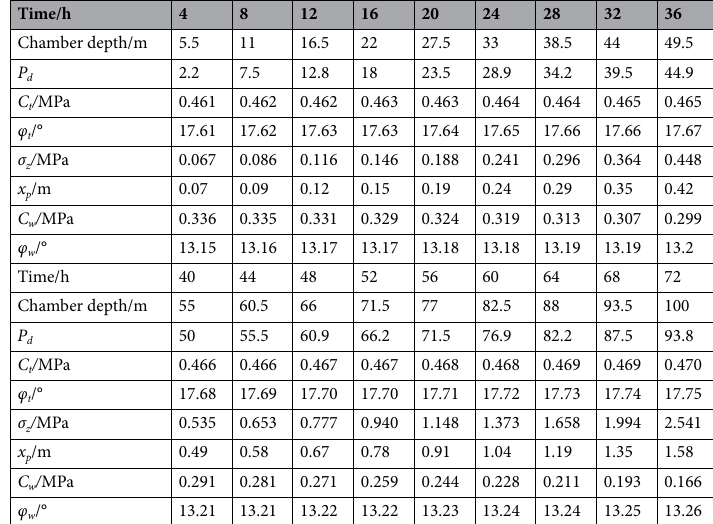
Table 5. Slice width distribution pattern and evolution weak layer parameters of a 6.0-m-wide coal pillar.